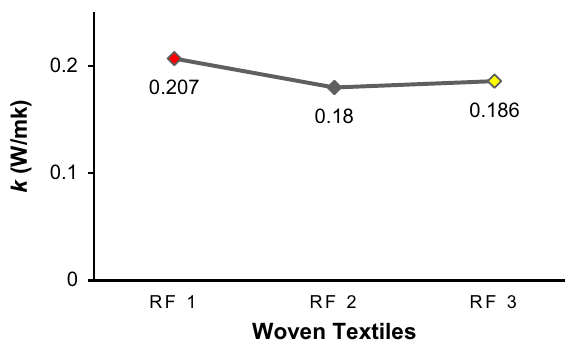
Fig. 14 Thermal conductivity of samples—k(W/mk). RF Reflective fabric